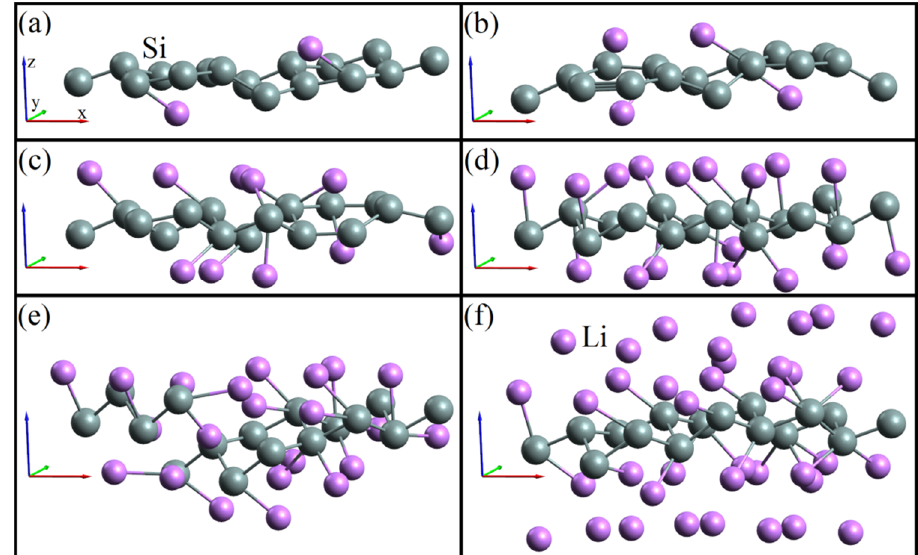
Figure 2. Geometric structures of a single-layer free-standing silicene, which adsorbed lithium in relation to silicon: ( a ) 0.125, ( b ) 0.25, ( c ) 0.625, ( d ) 1.125, ( e ) 1.375, and ( f ) 2.375.